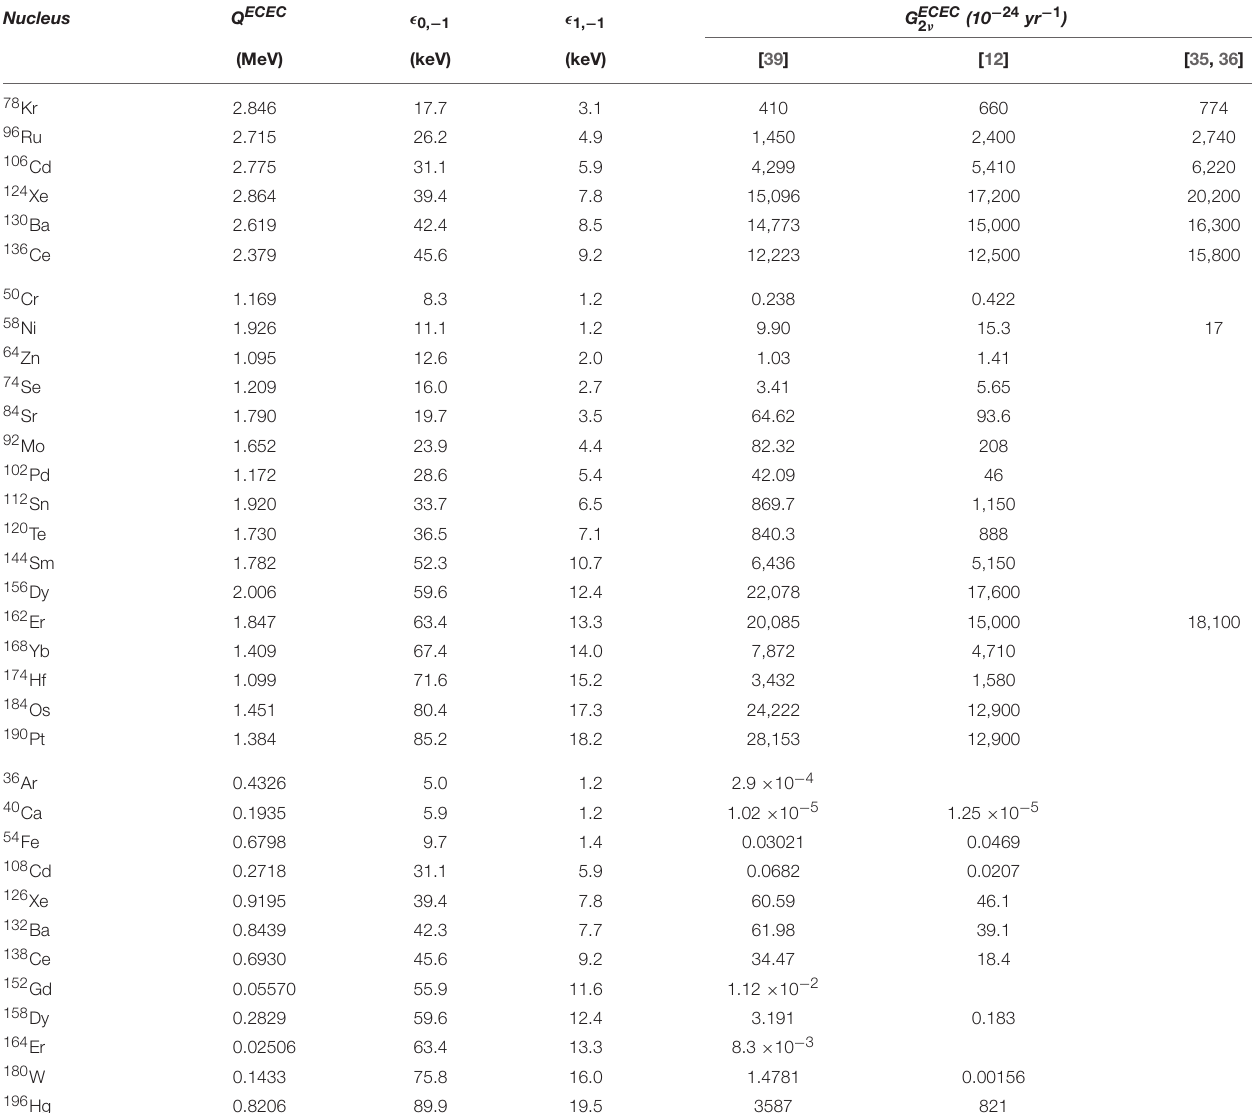
TABLE 7 | PSF for 2 ν ECEC decay mode.